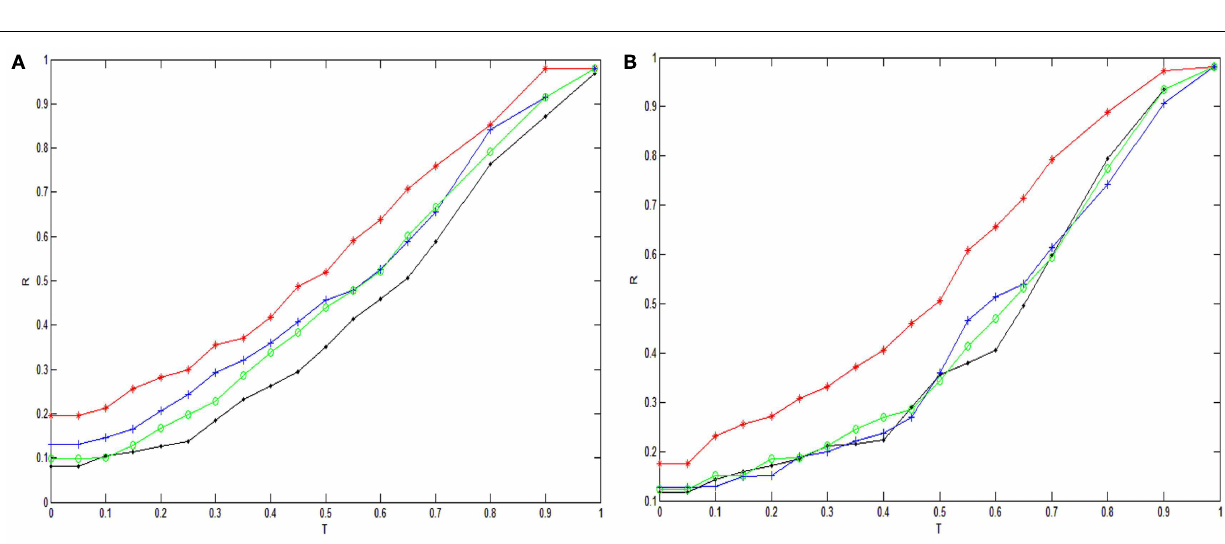
FIGURE 2 | Plots of the average size-ratio of cascading failure R versus threshold values used to construct mutual information networks. The red, black, blue, and green curves correspond to the cases of the normal state, stage II, stage III, stage IV respectively. (A) and (B) correspond to glioma and renal cancer.